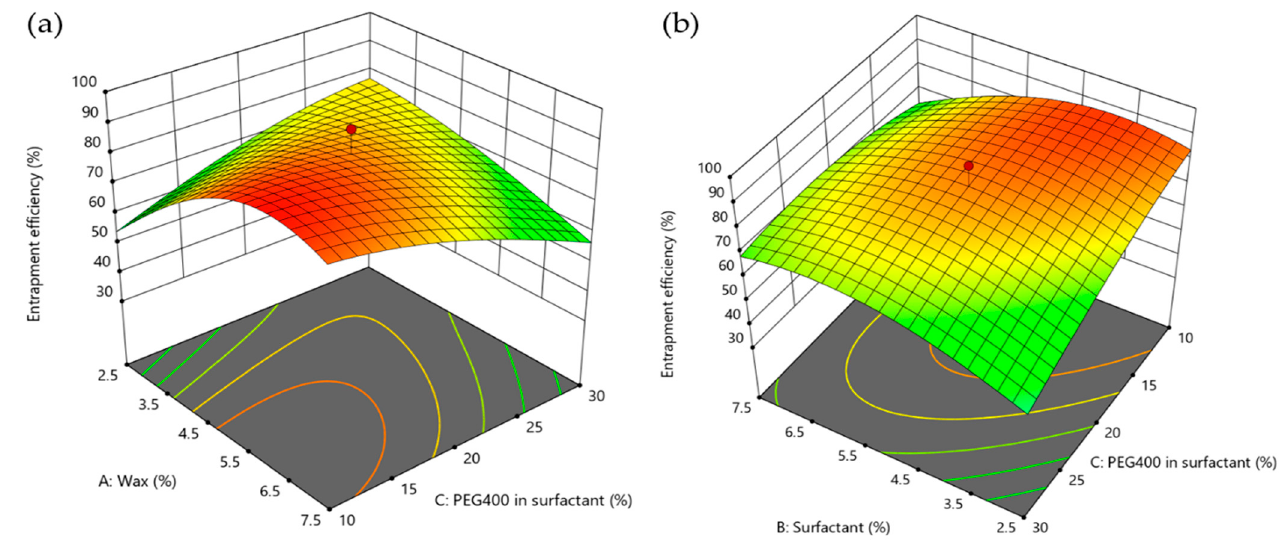
Figure 4. The response surface plot presents the effects of wax, surfactant, and PEG percentage in the surfactant on the entrapment efficiency of the SBO-NLCs. ( a ) Interaction of wax and PEG400 percentage in the surfactant. ( b ) Interaction of surfactant and PEG400 percentage in the surfactant. The wax (%) ( p = 0.003) and surfactant concentration (%) ( p = 0.013) and %wax 2 ( p = 0.0225) significantly influenced the particle size of the SBO-NLCs. Surfactant concentration (%; p = 0.0083), wax × surfactant concentration (%; p = 0.240), and %surfactant × %PEG400 in surfactant ( p = 0.0017) significantly manipulated the PDI of the SBO-NLCs.